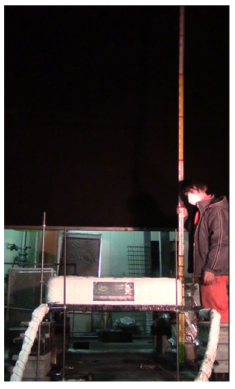
Figure 2. Measurement method of flame height (HB = 515 mm).